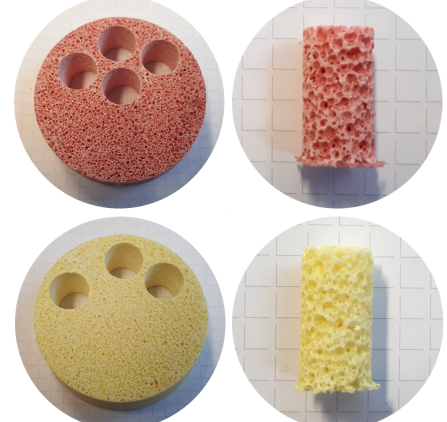
Figure 1. Examples of CaP (red) and CaC (yellow) foams as casted (left) and the final specimens after hollow-core drilling (right).